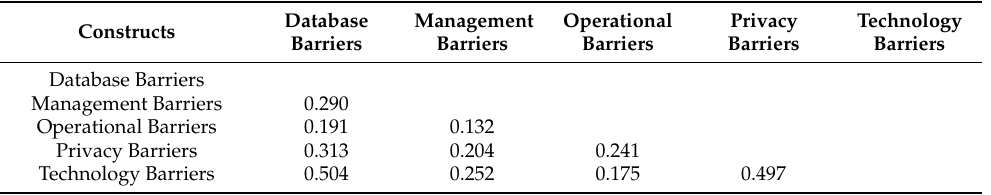
Table 6. Fornell larker criterion for discriminant validity.